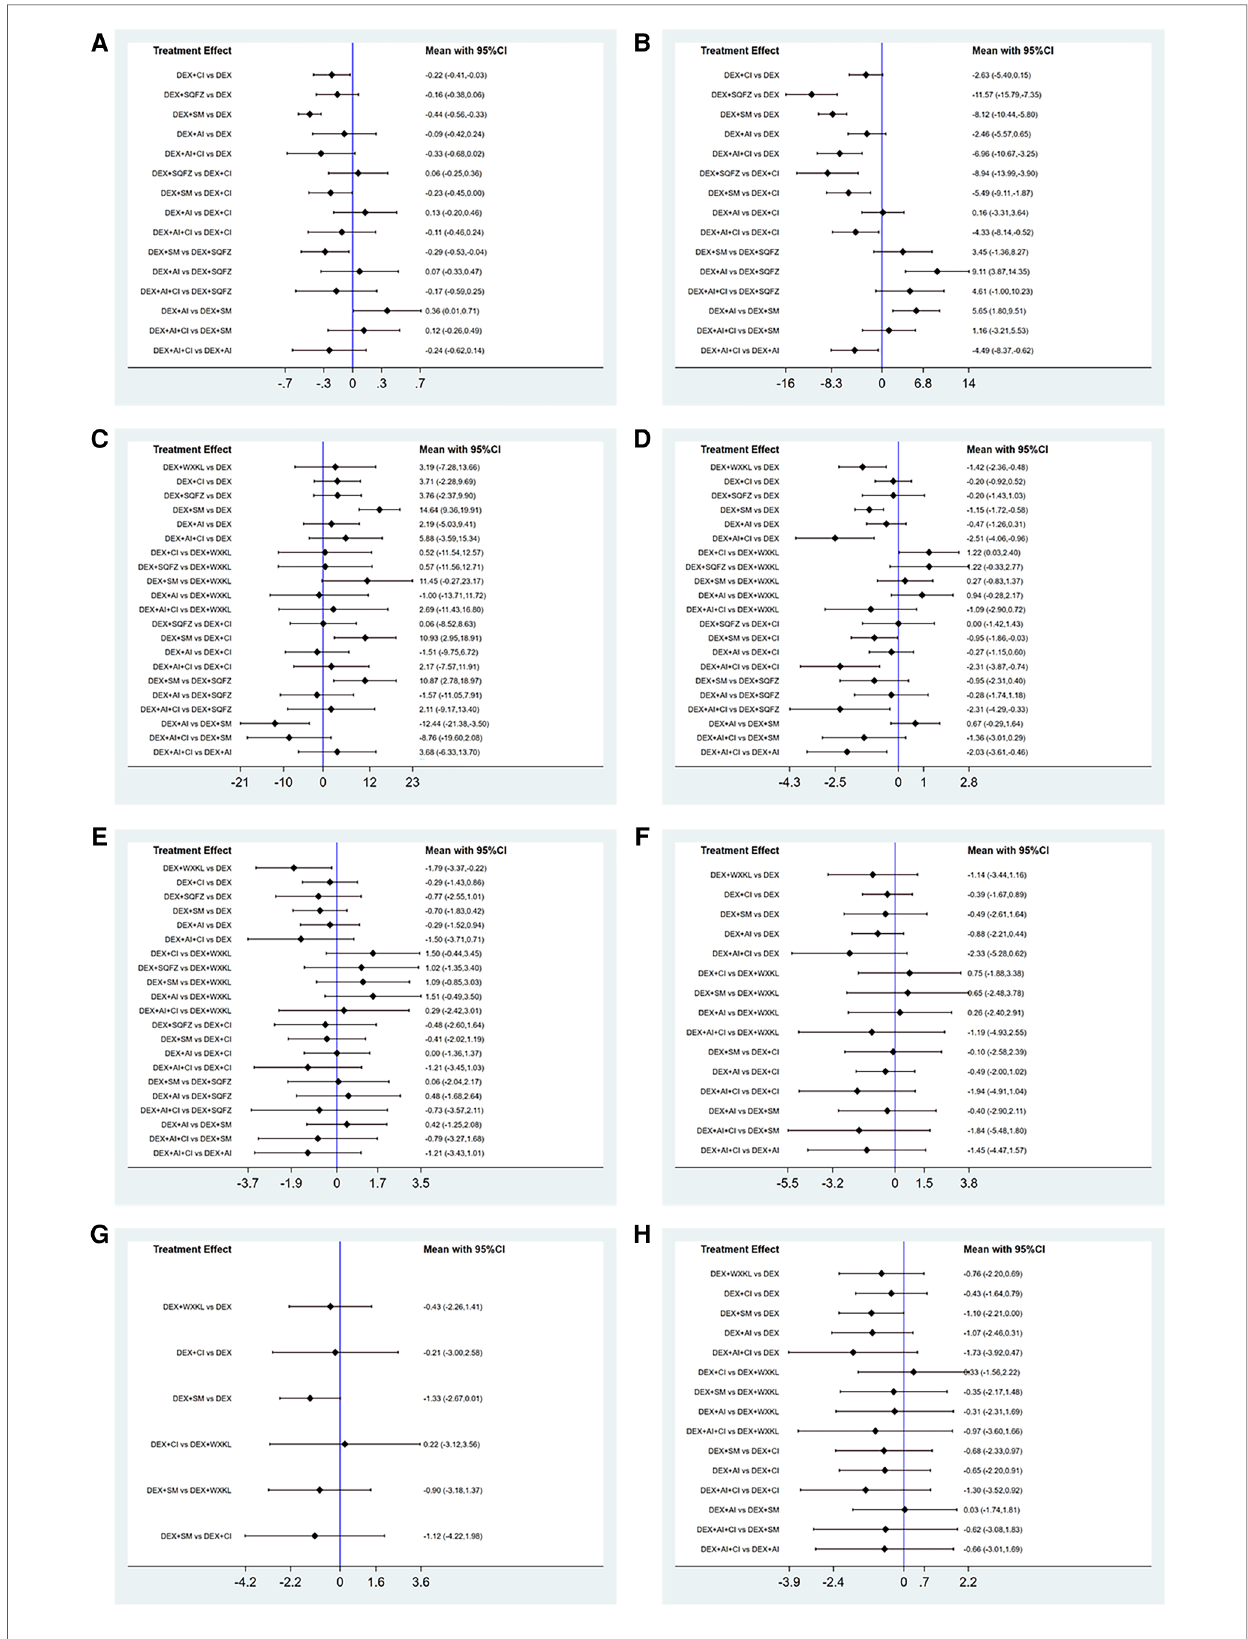
FIGURE 4 Forest plot of the studies included. ( A ) cTnI. ( B ) CK-MB. ( C ) LVEF. ( D ) Rate of abnormal of ECG. ( E ) ST-T change abnormal. ( F ) Sinus tachycardia. ( G ) Atrioventricular block. ( H ) Premature beat (DEX, Dexrazoxane; DEX+WXKL, Dexrazoxane combined with Wenxinkeli; DEX+CI, Dexrazoxane combined with Cinobufotalin injection; DEX+SQFZ, Dexrazoxane combined with Shenqifuzheng injection; DEX+SM, Dexrazoxane combined with Shenmai injection; DEX+AI, Dexrazoxane combined with Astragalus injection; DEX+AI+CI, Dexrazoxane combined with Astragalus with Cinobufotalin